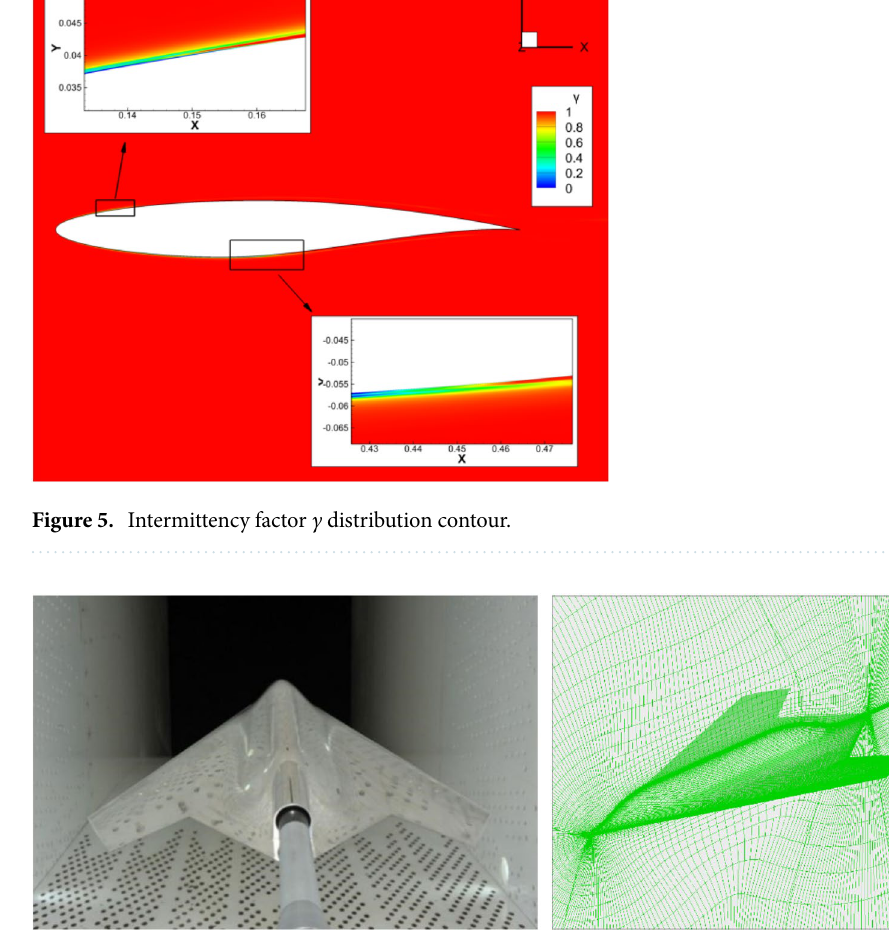
Figure 6. Test model and computational grid.